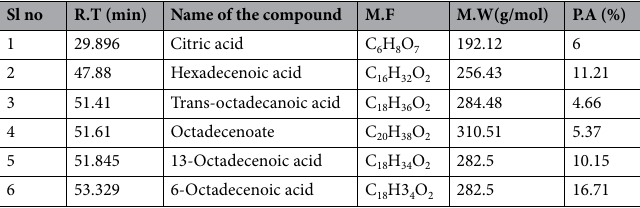
Table 10. Relative percentage of fatty acids in Kadukkai (T. chebula).